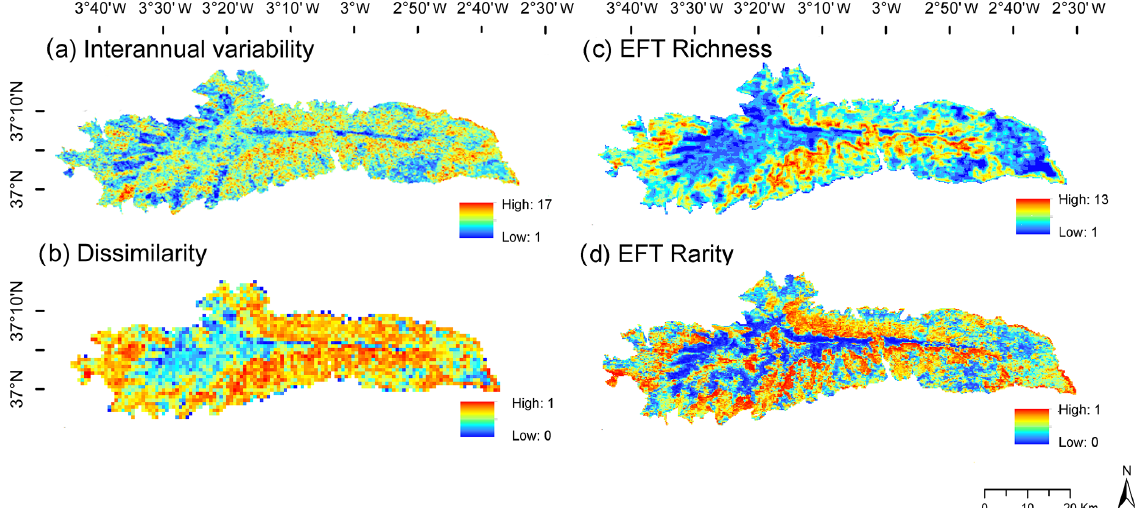
Figure 5. Functional-diversity and functional-stability patterns based on the identification of EFTs derived from EVI images captured by the MOD13Q1-TERRA sensor along the 2001–2018 period. (a) EFT interannual variability for the period, i.e., the number of EFTs that occurred at each pixel throughout the period; (b) EFT interannual dissimilarity (1 – Jaccard index), i.e., the mean interannual dissimilarity of EFT composition in 4 × 4 MODIS-pixel windows between all possible combinations of pairs of years throughout the period; (c) spatial EFT richness patterns, i.e., the number of different EFTs observed in a 4 × 4 MODIS-pixel sliding window (232m × 4 = 1km 2 ); (d) spatial EFT rarity patterns, i.e., a measure of the relative scarcity or abundance of each EFT in the study